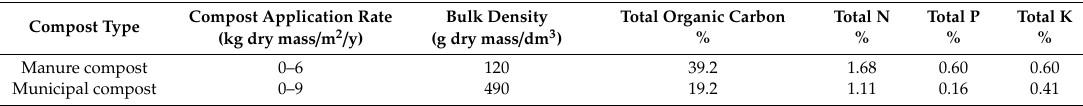
Table 1. Application rates and characteristics of compost used in this